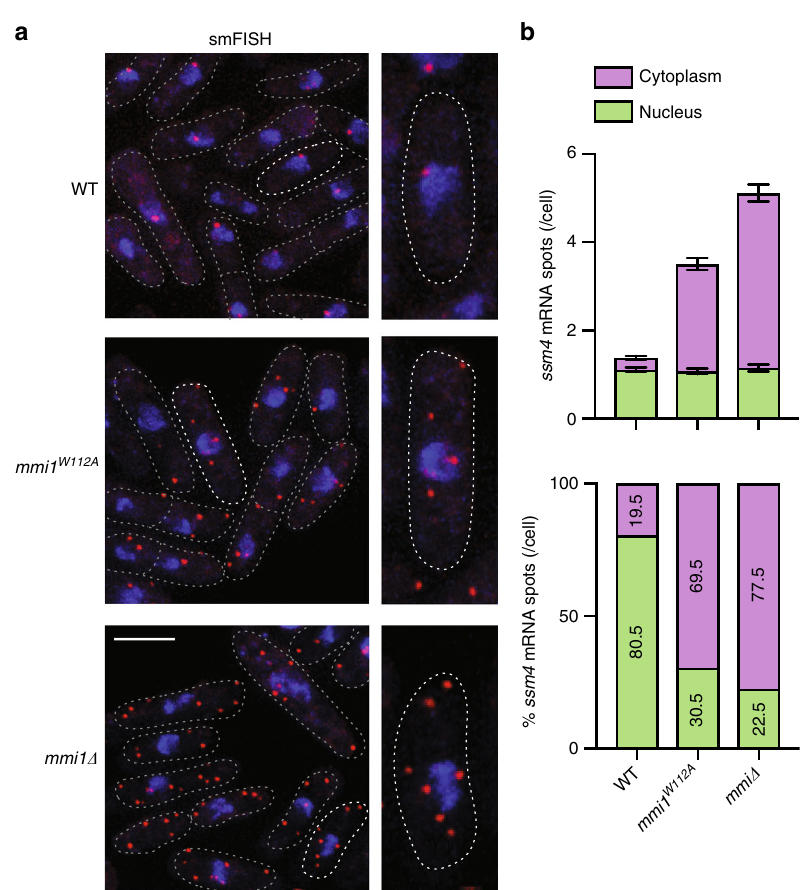
Fig. 7 EMC assembly is critical for nuclear retention of gametogenic gene transcripts in mitotic cells. a Representative images of the EMC target ssm4 mRNA (red) detected by Single molecule RNA Fluorescence In-Situ Hybridization (smFISH). DNA was stained with DAPI (blue). Images are shown as the maximum-intensity projections of Z -stacks. Dotted lines indicate the outline of cells. Scale bar (white) represents 5 μ m. b Quanti fi cation of nuclear and cytoplasmic localization of ssm4 mRNA. The upper panel shows the mean ± SEM from more than 140 cells and the lower panel indicates the distribution of the percentages of ssm4 mRNA